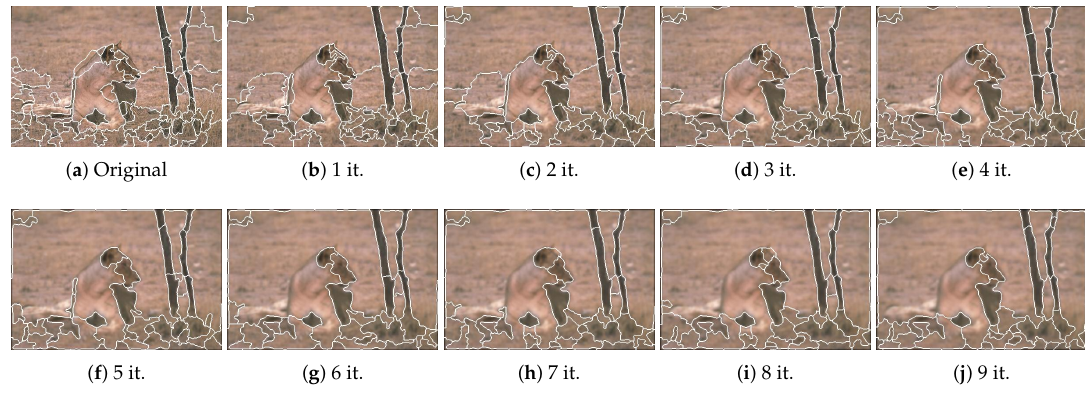
Figure 11. JSEG segmentation results for image 105027—the original and after applying the Gaussian filter for the specified number of